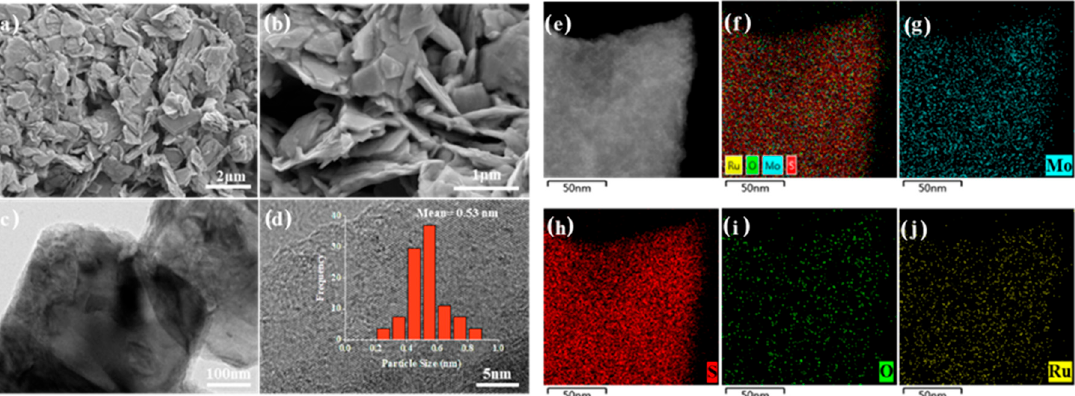
Figure 4. ( a , b ) SEM images, ( c , d ) TEM images and ( e – j ) element mapping of the 2RuO x /MoS 2 catalyst. Table 3. Elemental analysis of catalysts and product solution by ICP-OES.